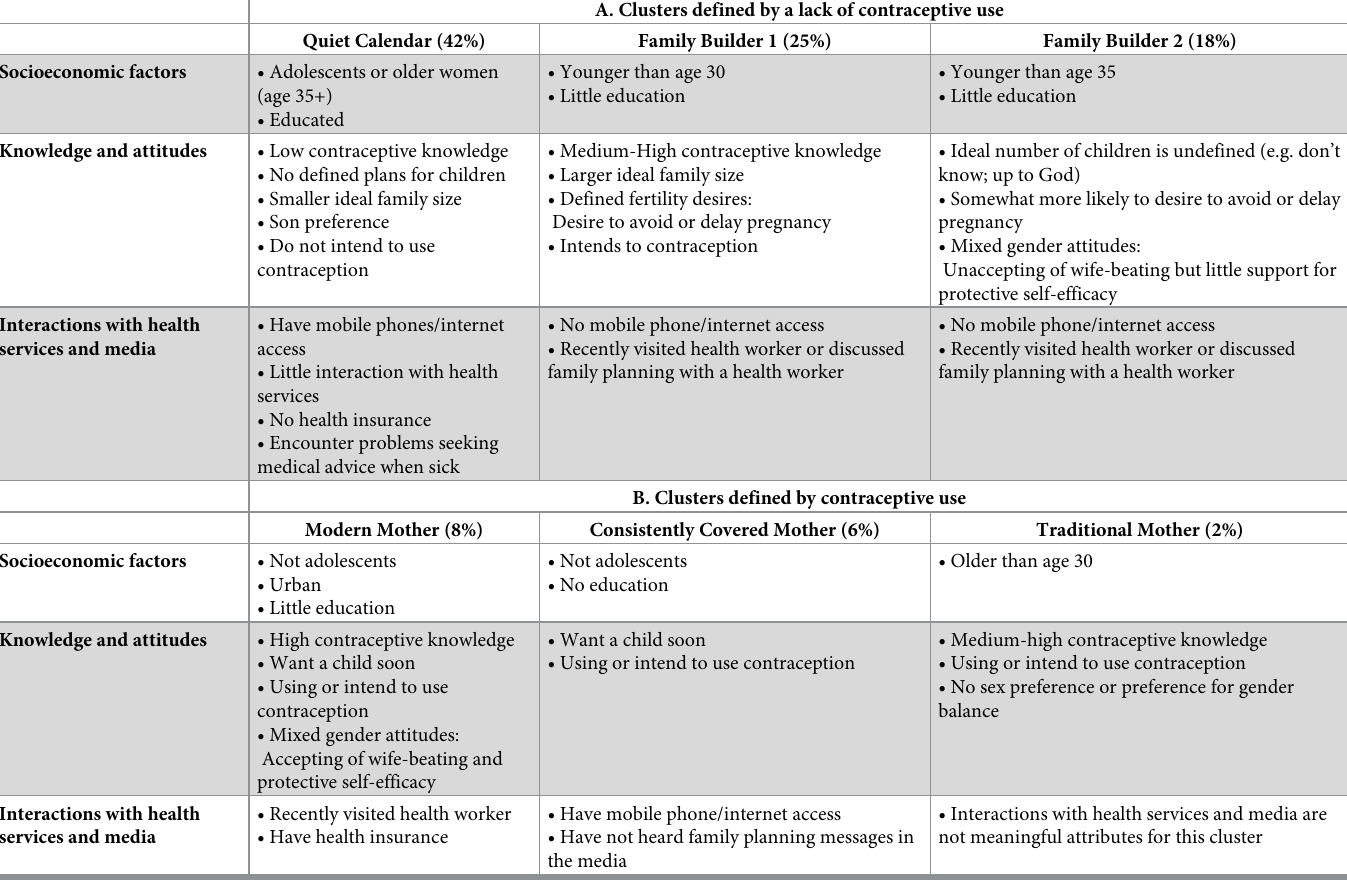
Table 3. Summary profiles of clusters defined by a lack of contraceptive use (panel A) and by contraceptive use (panel B). A. Clusters defined by a lack of contraceptive